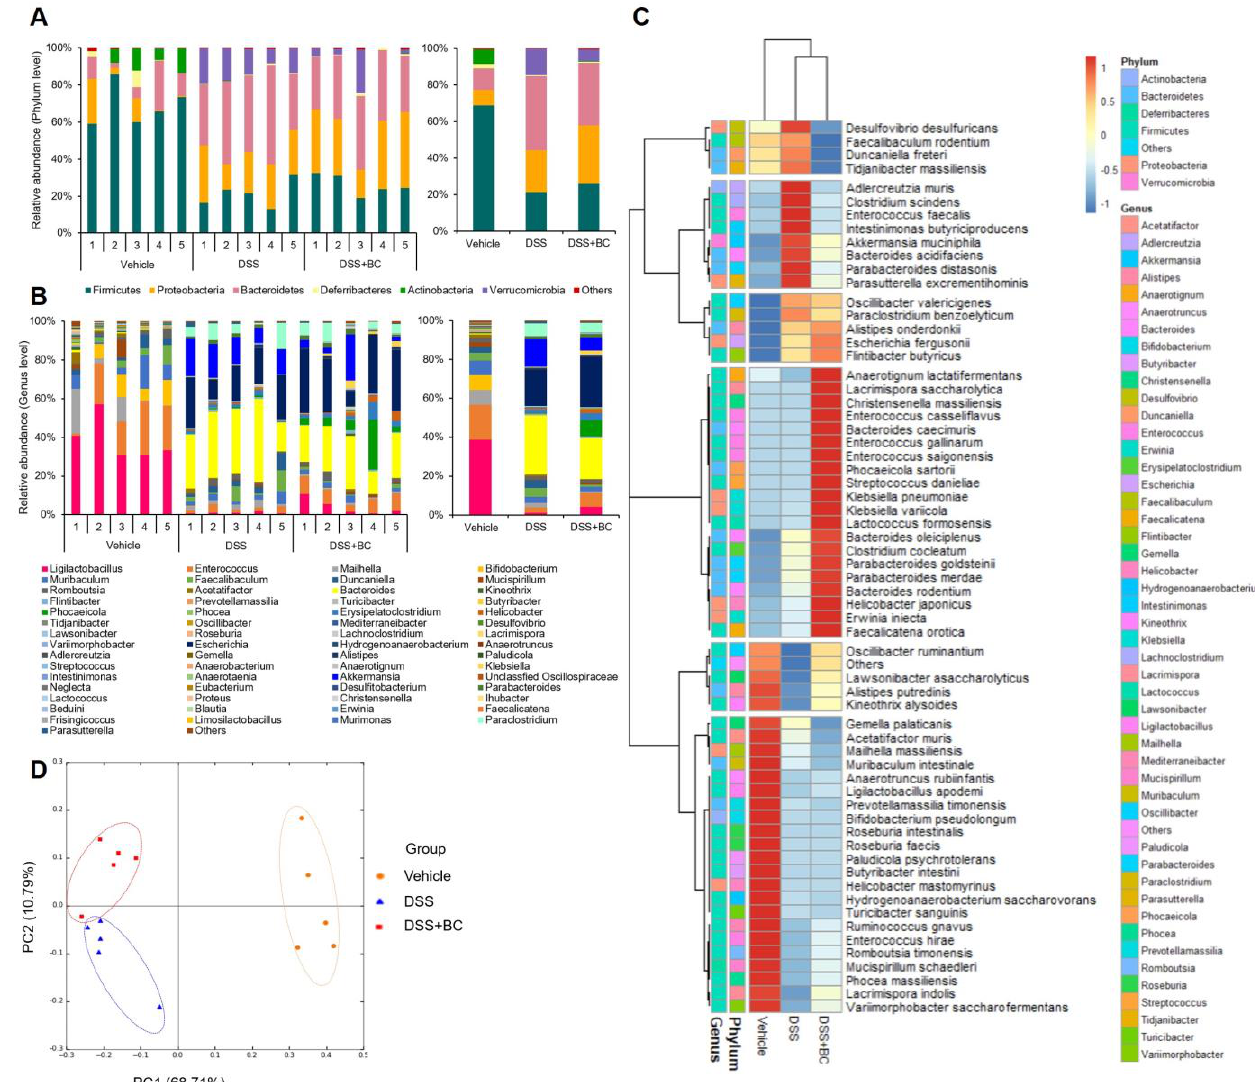
Figure 4. Effects of blackcurrant on gut microbiota on microbiota in DSS − induced colitis. ( A ) Taxonomy community analysis at the phylum levels; ( B ) taxonomy community analysis at the genus levels ( ≥ 0.03%); ( C ) heatmap analysis showing normalized abundance at the species levels; ( D ) principal coordinate analysis (PCoA) plots of gut microbiota of each group. The values are shown as mean ± SD ( n = 5 per group). Vehicle, normal control group not treated with DSS; DSS, DSS control group; BC; DSS + blackcurrant group.